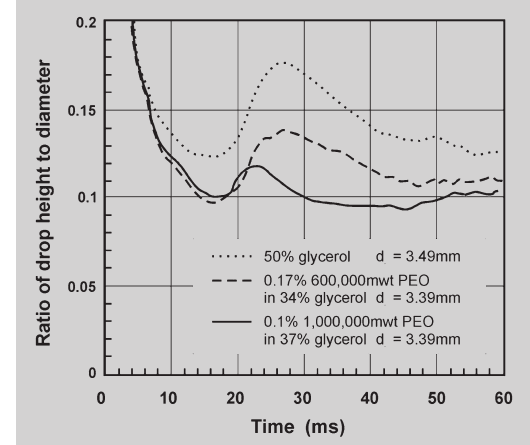
Figure 11: Ratio of drop height to diameter as a function of time for a drop spreading over a glass plate. Drop impacted the glass plate at 1.5